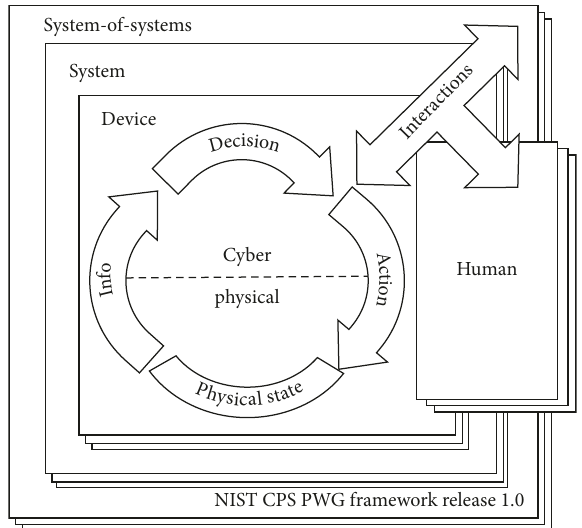
Figure 1: CPS conceptual